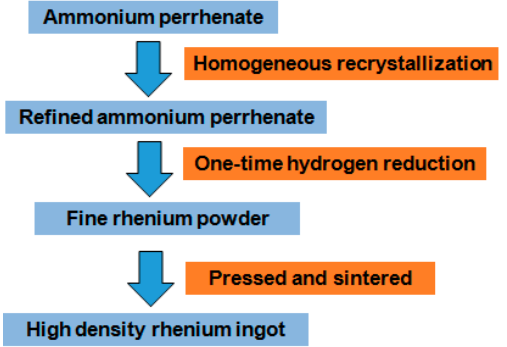
Figure 11. Proposed flow sheet for the preparation of high-density rhenium ingot by homogeneous recrystallization of ammonium perrhenate by a hydrogen reduction.